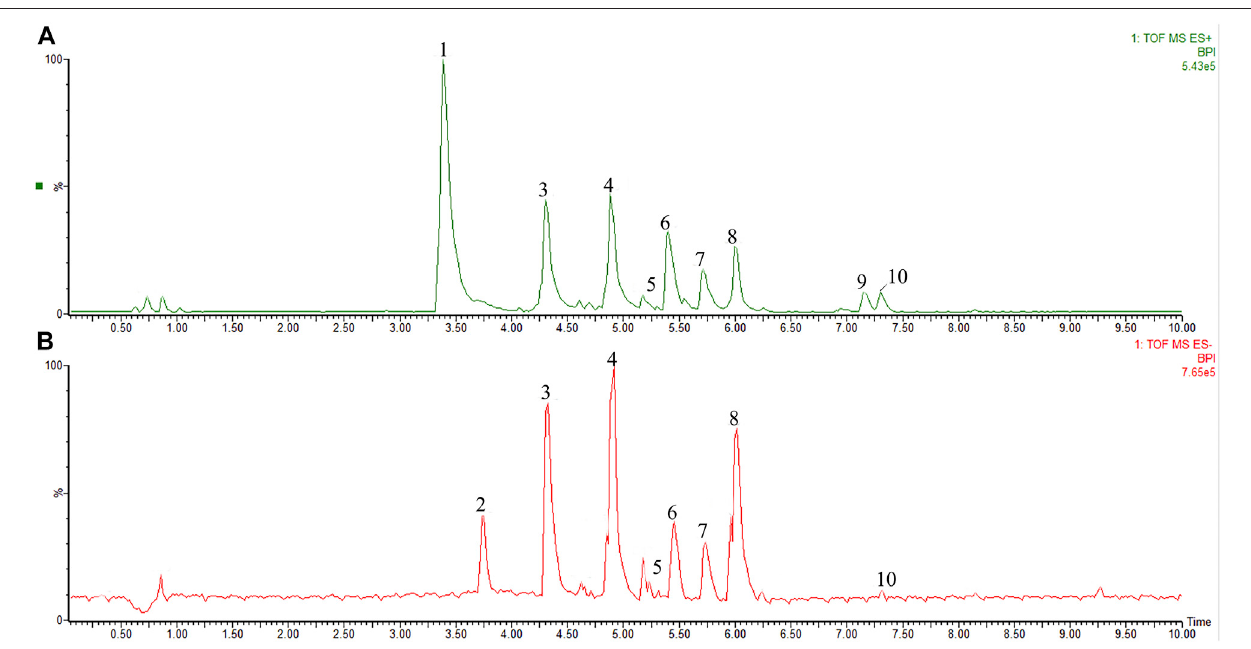
FIGURE1| ThecharacterizationofTFLSchemicalpro fi le. (A) positiveionmode; (B) negativeionmode;1)Unknown(C 11 H 18 N 3 O);2)2,5-Dihydroxybenzoicacid;3) 3-O-p-Coumaroylquinic acid; 4) Epicatechin; 5) Rutin; 6) Proanthocyanidin A1; 7) Proanthocyanidin A2; 8) Litchioside. (C) 9) Berberine; 10) (-)-Pinocembrin7-O-